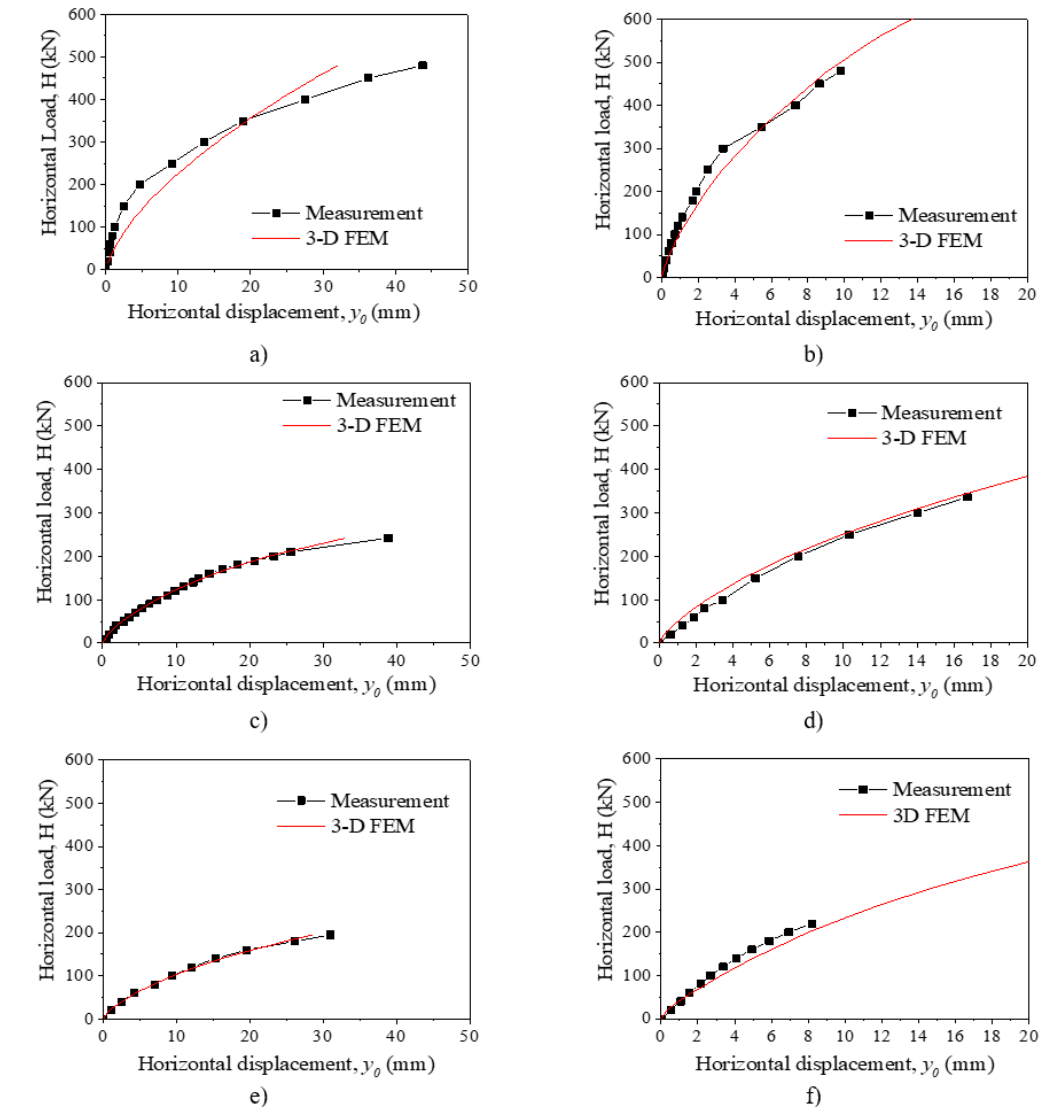
Figure 8. Comparison of the response of laterally loaded piles obtained from field tests and by numerical modelling: (a) CFA pile in Area A; (b) CFA pile in Area B; (c) steel pile HS1 in Area A; (d) steel pile HS1 in Area B; (e) steel pile HS2 in area A; (f) steel pile HS2 in Area B.